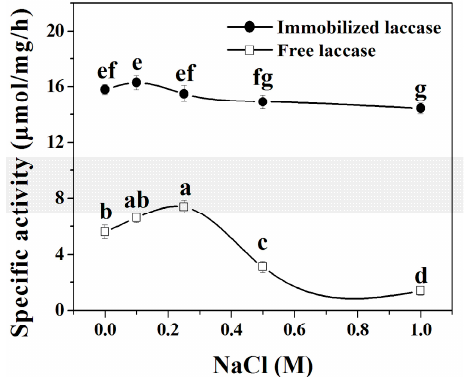
Figure 6. Effect of NaCl concentration on the activity of laccase and laccase in the nanoflowers. Reaction conditions: trans -resveratrol 2 mmol, n -butanol (30 mL), Na 2 HPO 4 –sodium citrate buffer (15 mL) containing 0.0–1.0 M NaCl (pH 5.0 for immobilized laccase, pH 4.0 for free laccase), immobilized